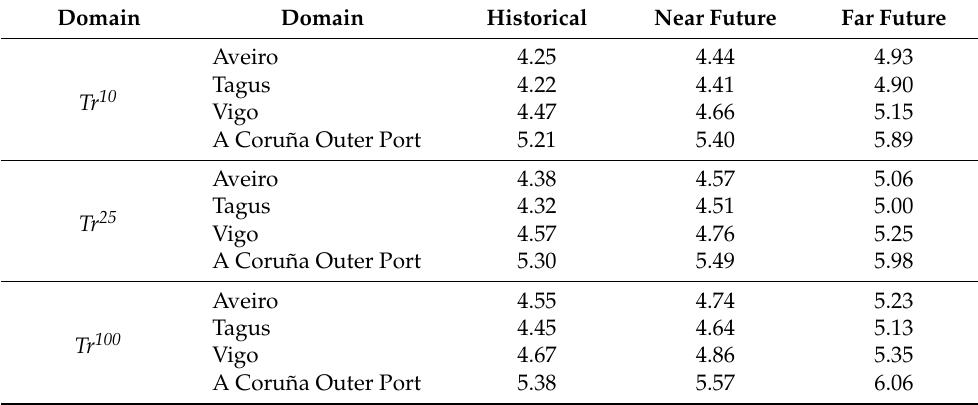
Table 3. Extreme sea level (ESL, in meters) for historical, near future and far future, considering a simultaneous high tide and storm surge, with return periods ( Tr ) of 10, 25 and 100 years. Domain